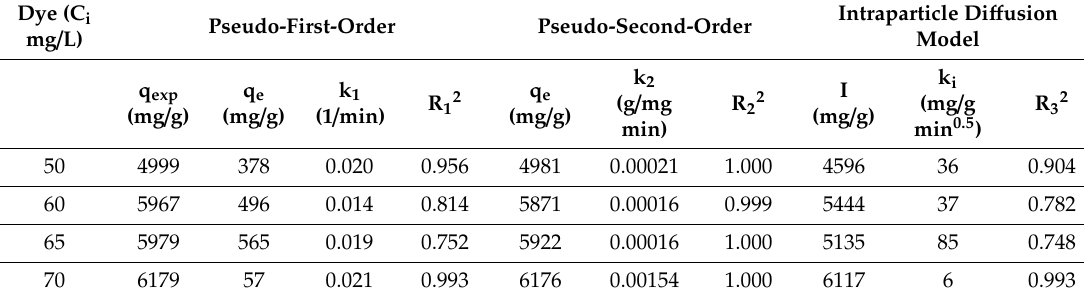
Table 3. MB removal by Fe 2 (MoO 4 ) 3 kinetic parameters.